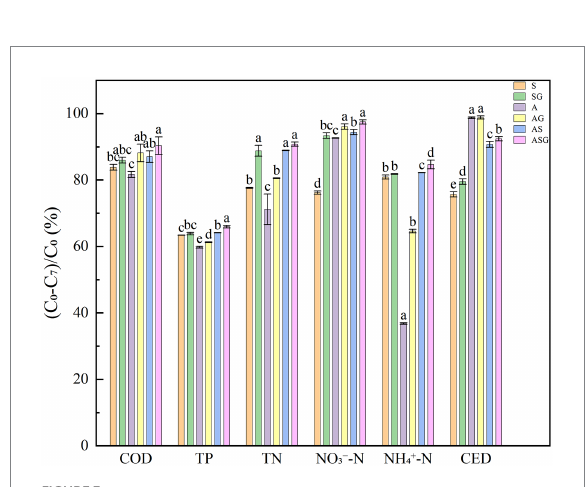
FIGURE 3 Final removal rate of pollutants in different microcosmic systems. Different letters indicate p < 0.05, with significant difference.